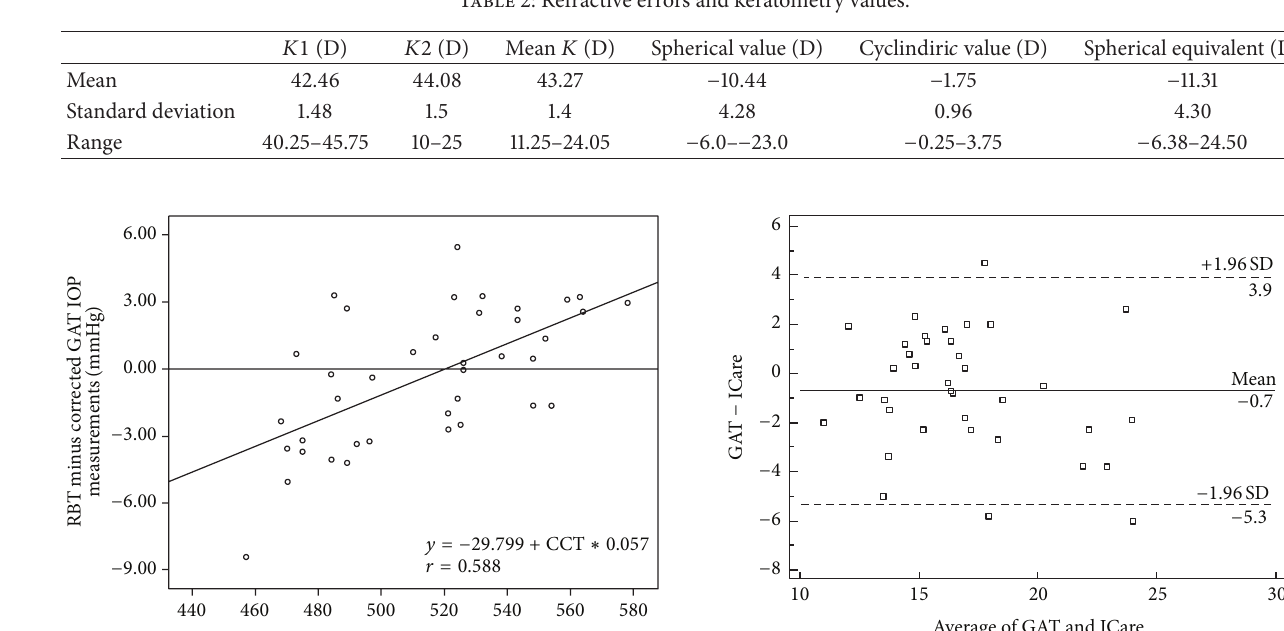
( 𝑃 = 1.000 ), indicating that the RBT and GAT results were in good agreement.